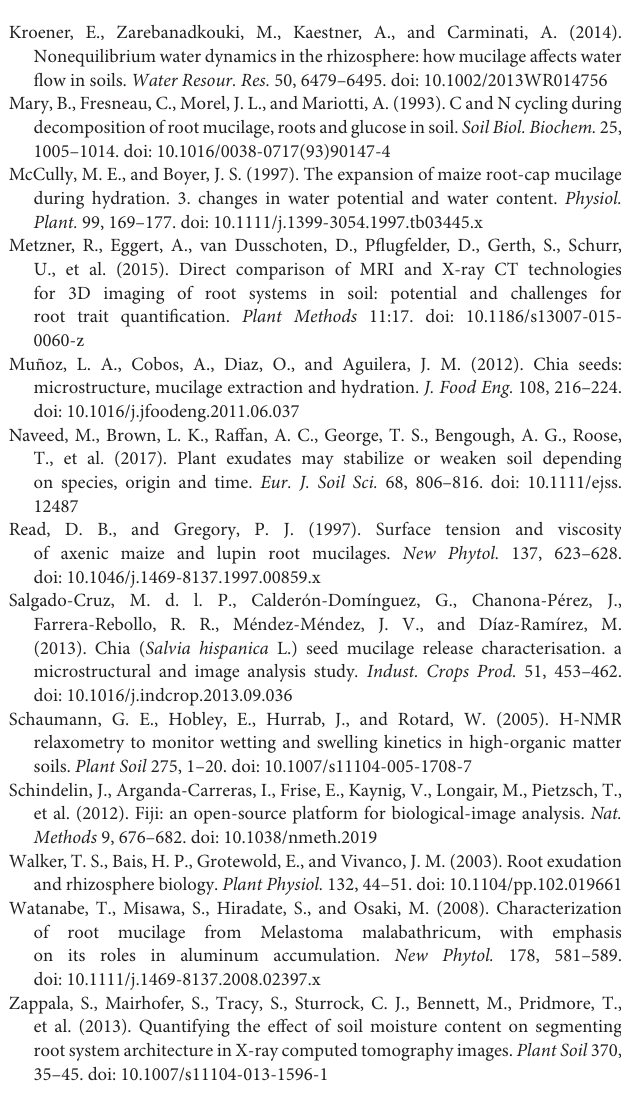
Figure S1 | Three-dimensional segmentation of chia mucilage degradation in quartz loose region at t = 0h and t = 168h. Figure S2 | Three major image processing steps on CT images. (a) Vertical raw CT slice after removal of capillary (black vertical stripe), (b) classification result of solid particle s (red) and liquid phase (blue) and airfilled voids